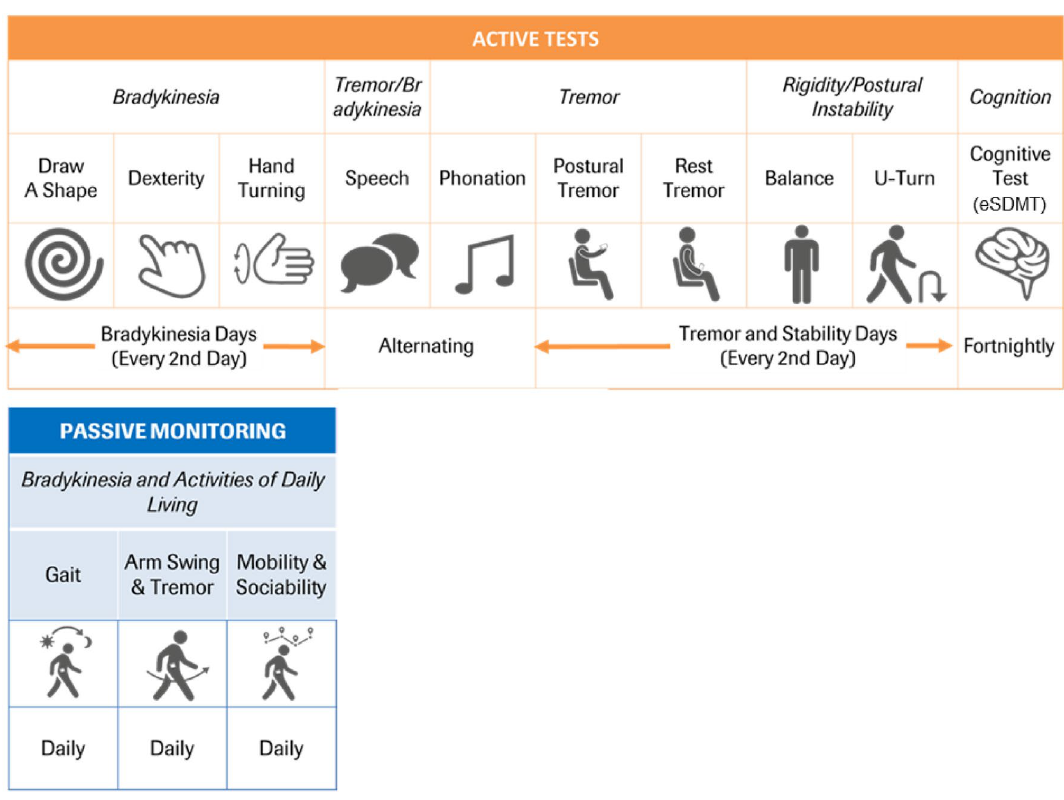
Figure 1. Roche PD Mobile Application v2 active tests and passive monitoring and schedule of assessments. eSDMT, electronic Symbol Digit Modalities Test; PD, Parkinson’s